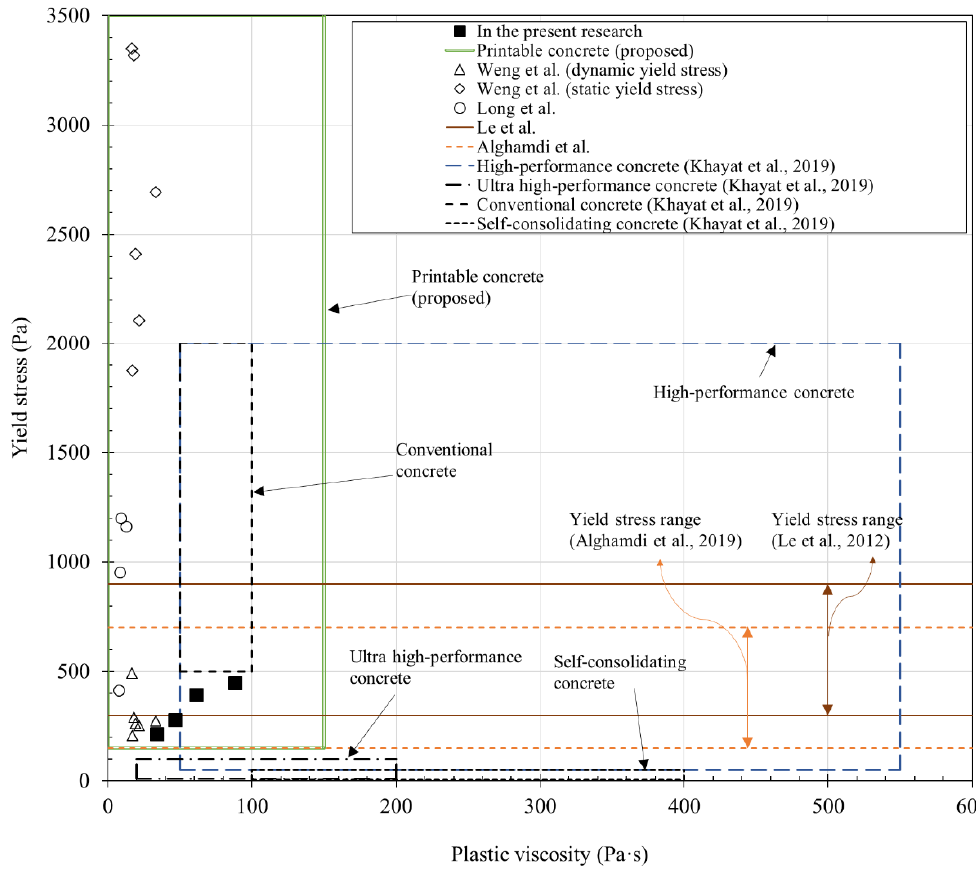
Figure 9. Rheological properties depending on concrete type [26–29]. Table 3. Typical yield stress and plastic viscosity ranges for different concrete mixtures (Adpated from Ref. [26]).